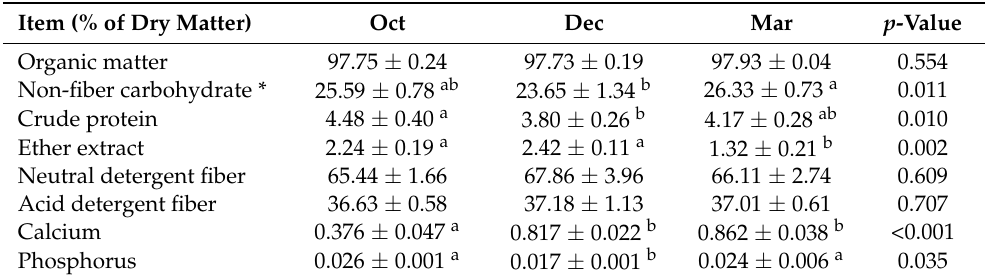
Values with different superscripts represented significant differences among groups ( p < 0.05). Re-